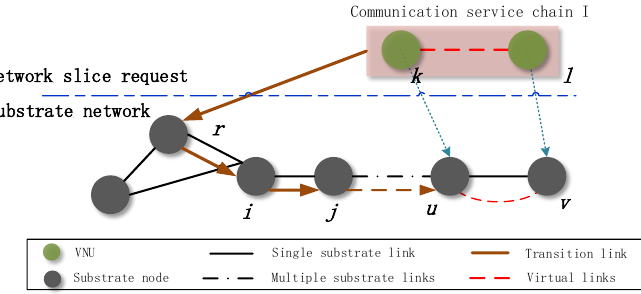
Figure 2. Illustration of virtual link